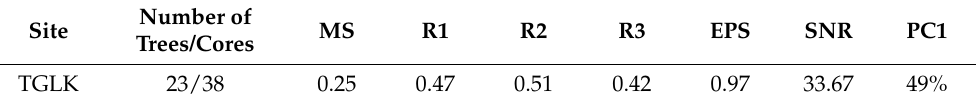
Table 1. Statistical characteristics for the standardised tree-ring width